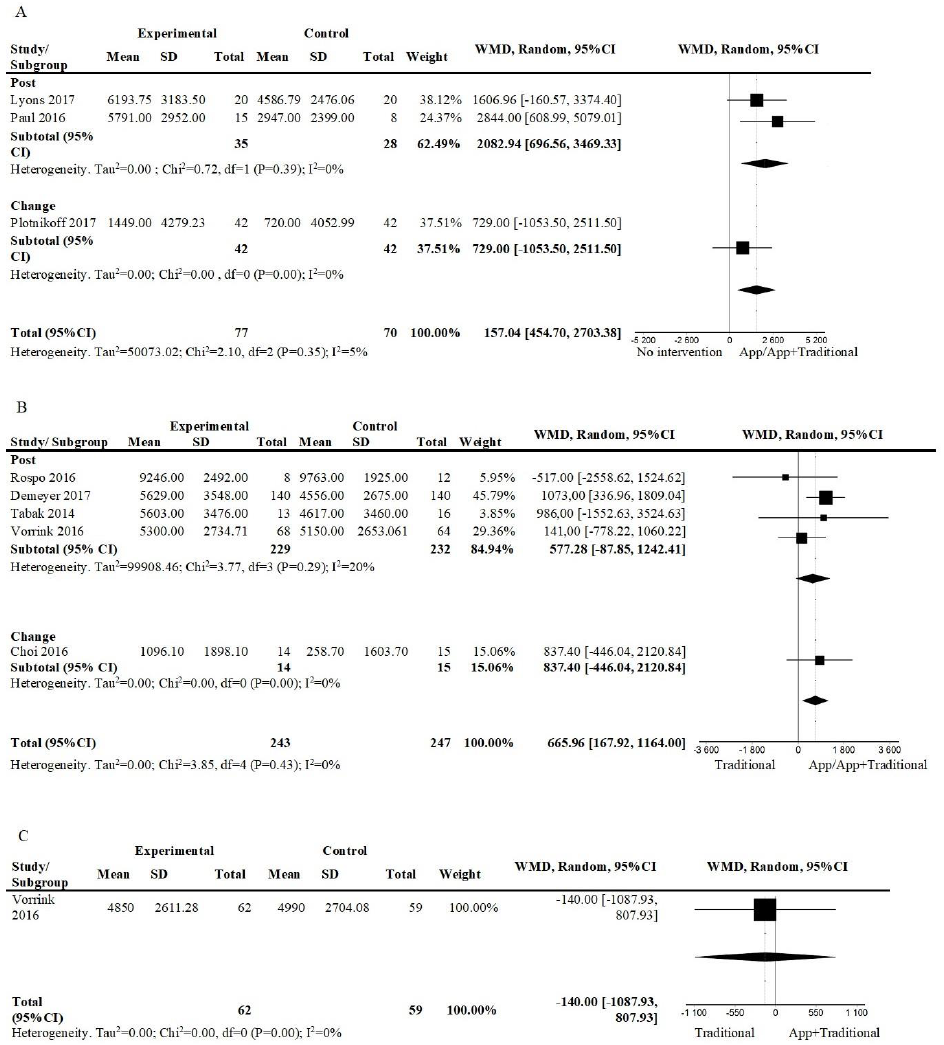
Figure 3. Forest plot of comparison, outcome: number of steps: ( A ) App / App + Traditional vs. No intervention, short term; ( B ) App / App + Traditional vs. Traditional, short term; ( C ) App + Traditional vs. Traditional, follow-up. Abbreviations: CI, confidence interval; df, degrees of freedom; WMD, weighted mean di ff